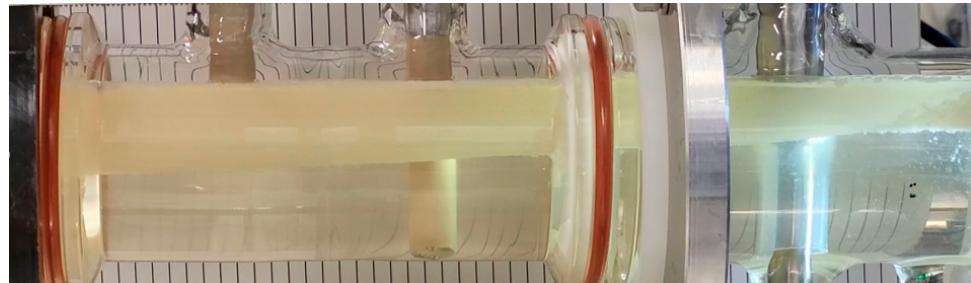
Figure 27. Photograph of continuously operated lying settler at ATPE trial with biomass.